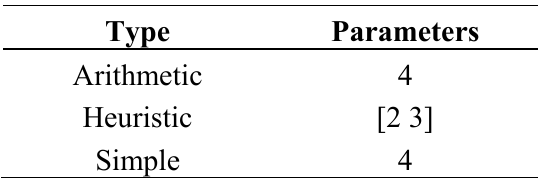
Table 4. Crossovers parameters.